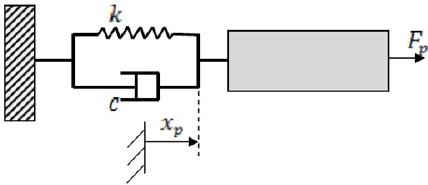
Figure 7. Physical model of the PE-SSA system (without friction) (Adriaens et al., 2000).